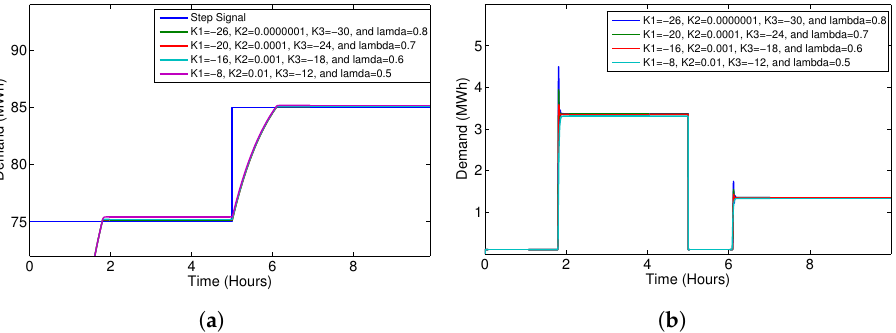
Figure 4. Step response analysis our proposed framework. ( a ) Demand Response. ( b ) Price